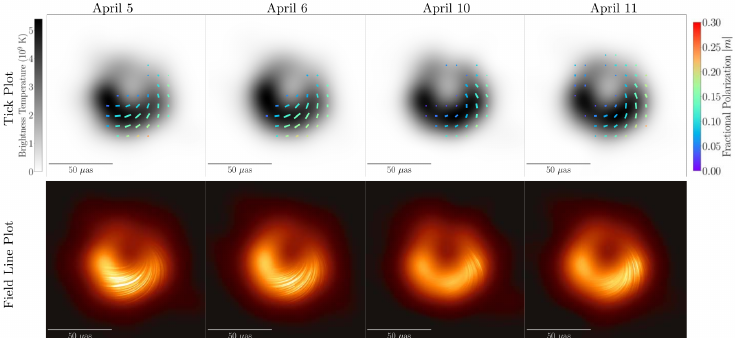
Figure 5. Fiducial linear polarimetric images of the M87 black hole observed with the EHT in 2017 [30]. Each image is an average of the five calibration/imaging methods for each day. The upper panel shows the total intensity distributions in grey color and the EVPAs with colored ticks with the colors scaling with the linearly polarized intensity distribution. The bottom panel shows the total intensity distribution in color, on top of which the black streamlines represent the observed EVPA